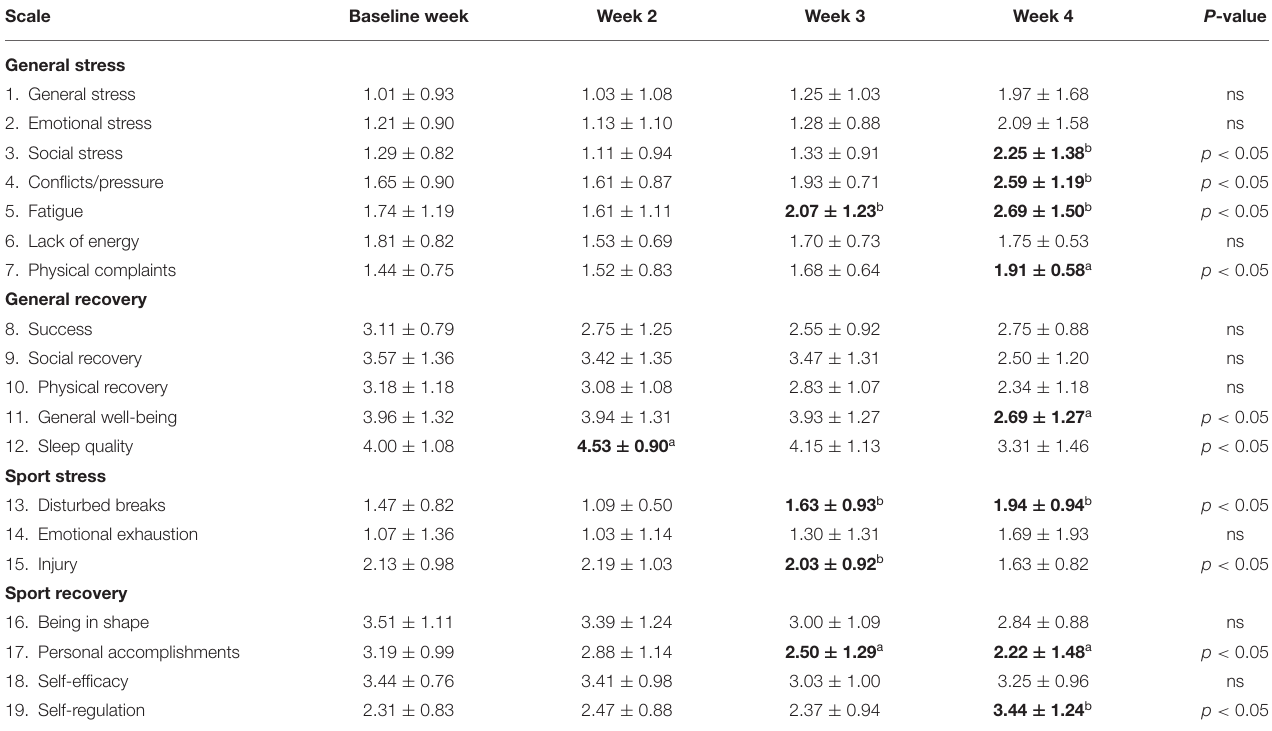
TABLE 1 | Average scores (mean ± SD) of the Recovery-Stress Questionnaire for Athletes (RESTQ-Sport) scales during the 4-week training period. Scale